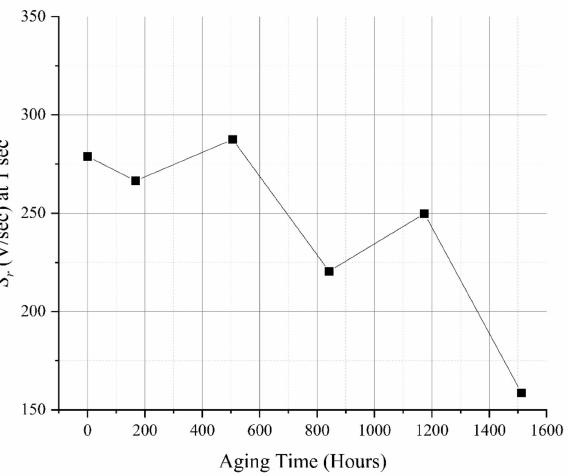
Figure 12. Change in ( a ) capacitance and ( b ) tan δ for different thermal aging periods at 10 mHz, 100 mHz, 100 Hz, 1 kHz, 100 kHz, and 500 kHz for CSPE jacket.